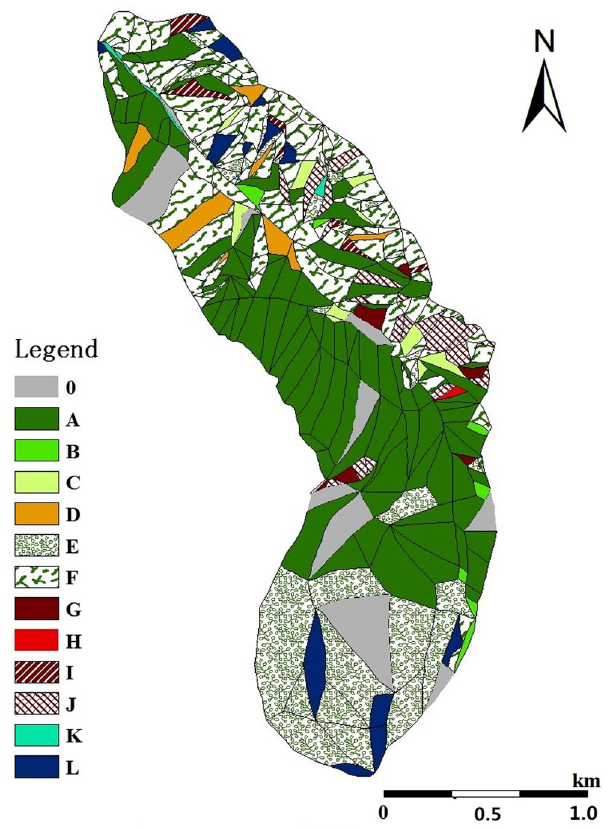
Figure 1. The distribution of vegetation cover types in Pailugou watershed (0 unmeasured units, (A)) Qinghai spruce forest, (B) Qinghai spruce woodland, (C) Qinghai spruce montane savanna shrub, (D) Qinghai spruce montane savanna grass, (E) shrub, (F) grassland, (G) Sabina przewalskii forest, (H) S. przewalskii woodland, (I) S. przewalskii montane savanna shrub, (J) S. przewalskii montane savanna grass, (K) watercourse, and (L) bare land. The legends are all the same in other figures thereafter). This map was generated using ArcGIS 10.3 software.